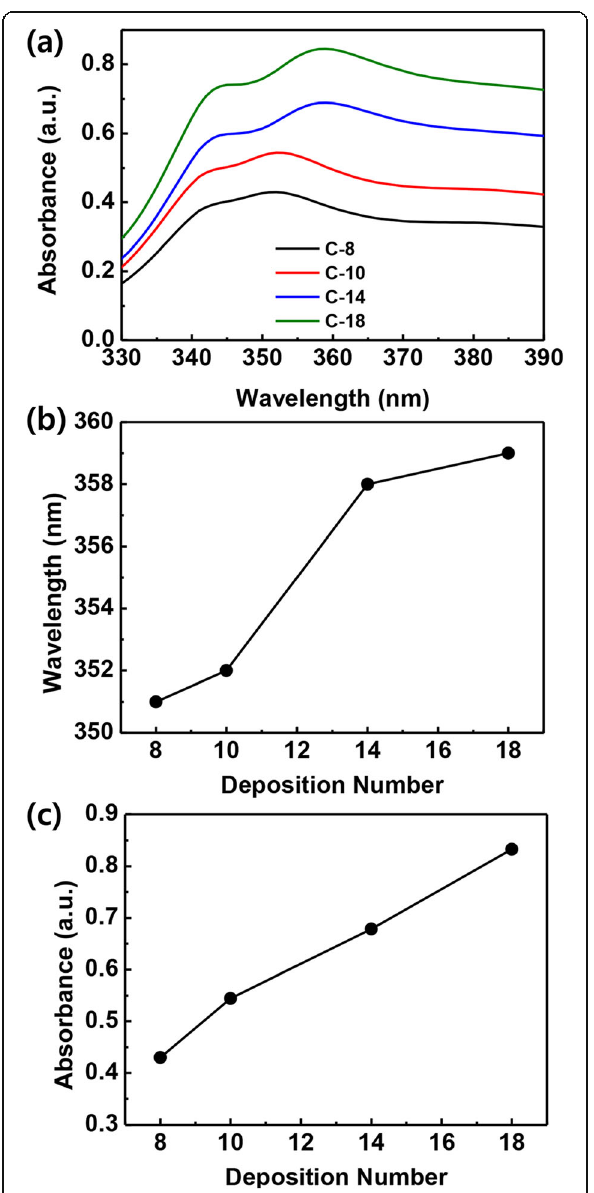
Fig. 3 a UV-vis absorption spectra of cross-AgNW films with different deposition numbers. b Shift in resonance wavelength as a function of deposition number. c Absorption intensities at the maximum